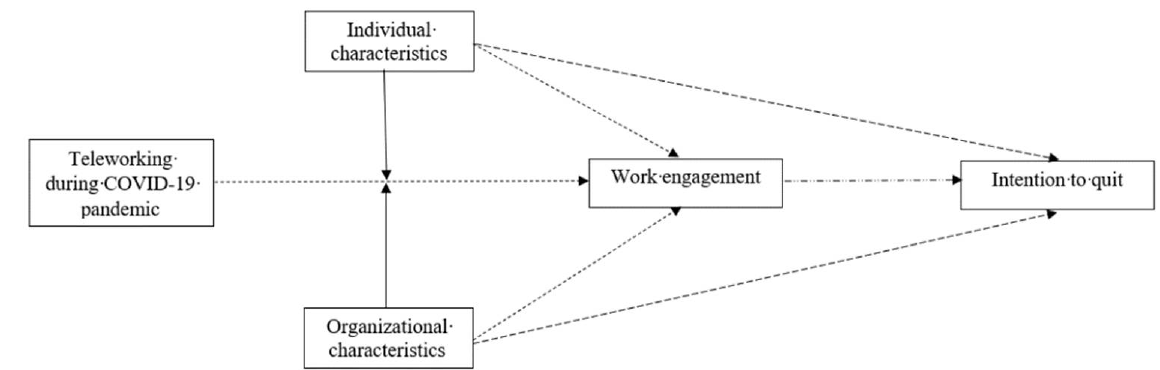
Figure 1. Hypothetical Model.